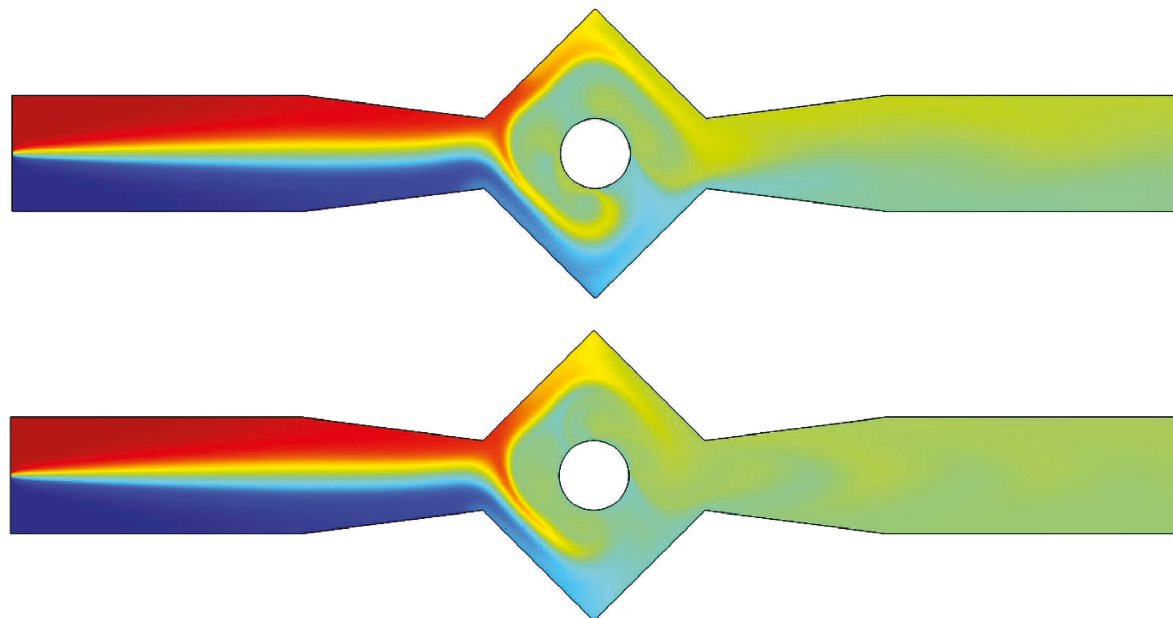
Figure 16: Contours of the changes in the concentration in the diamond-shaped mixing chamber when u � 0 . 1 [ mm / s ] , φ � π /2 , f � 5 [ Hz ] (up) and u � . 01 [ mm / s ] , φ � π /2 , f � 10 [ Hz ]